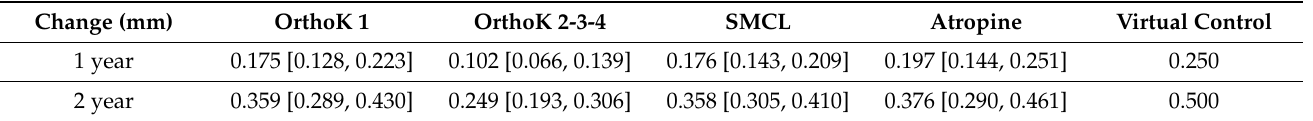
Table 7. Model estimated first and second year average AL progression (with 95% confidence interval) by modality. Change (mm)